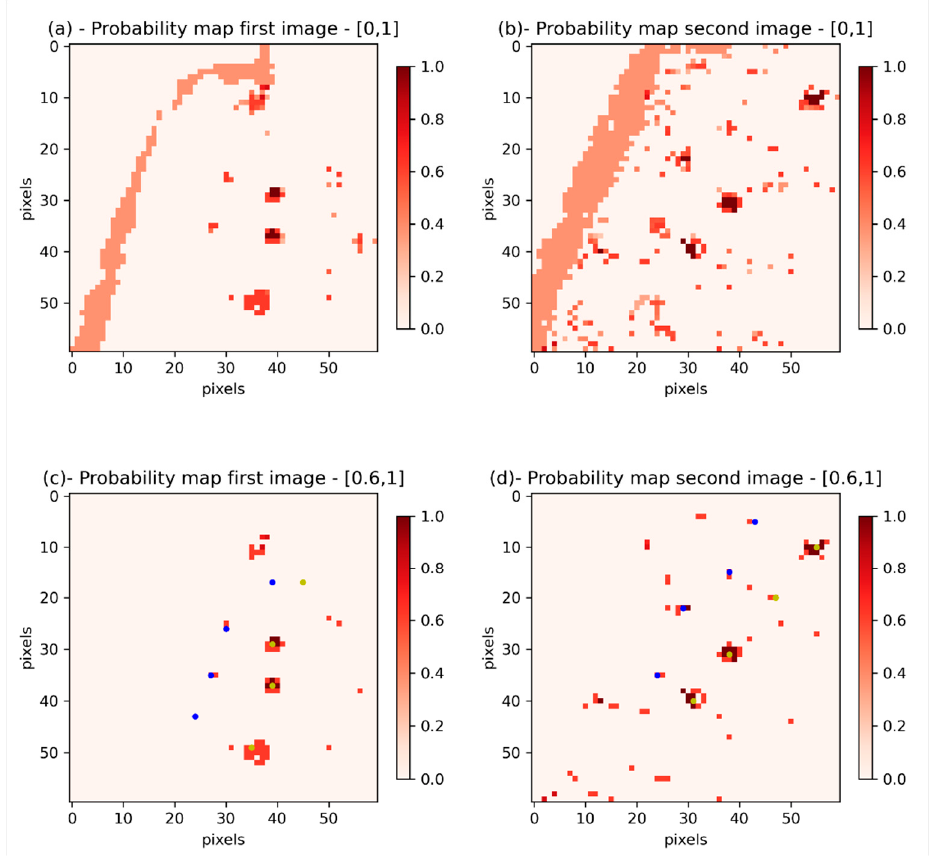
Figure 7. ( a , b ) Final maps where each pixel represents a value in the [0.10,1.00] interval as a linear combination of the weights; ( c , d ) the same final maps with values in the [0.6,1.00] interval.